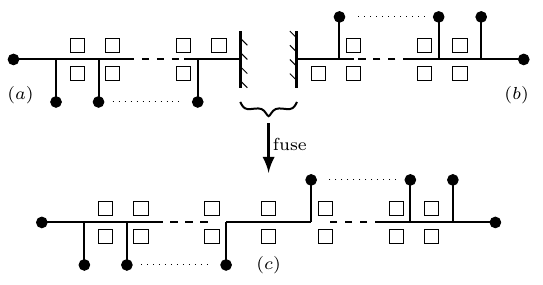
Figure 7 . Two bases on two disks, (a) and (b), can fuse along the boundaries of the disks into a basis on a sphere, (c).